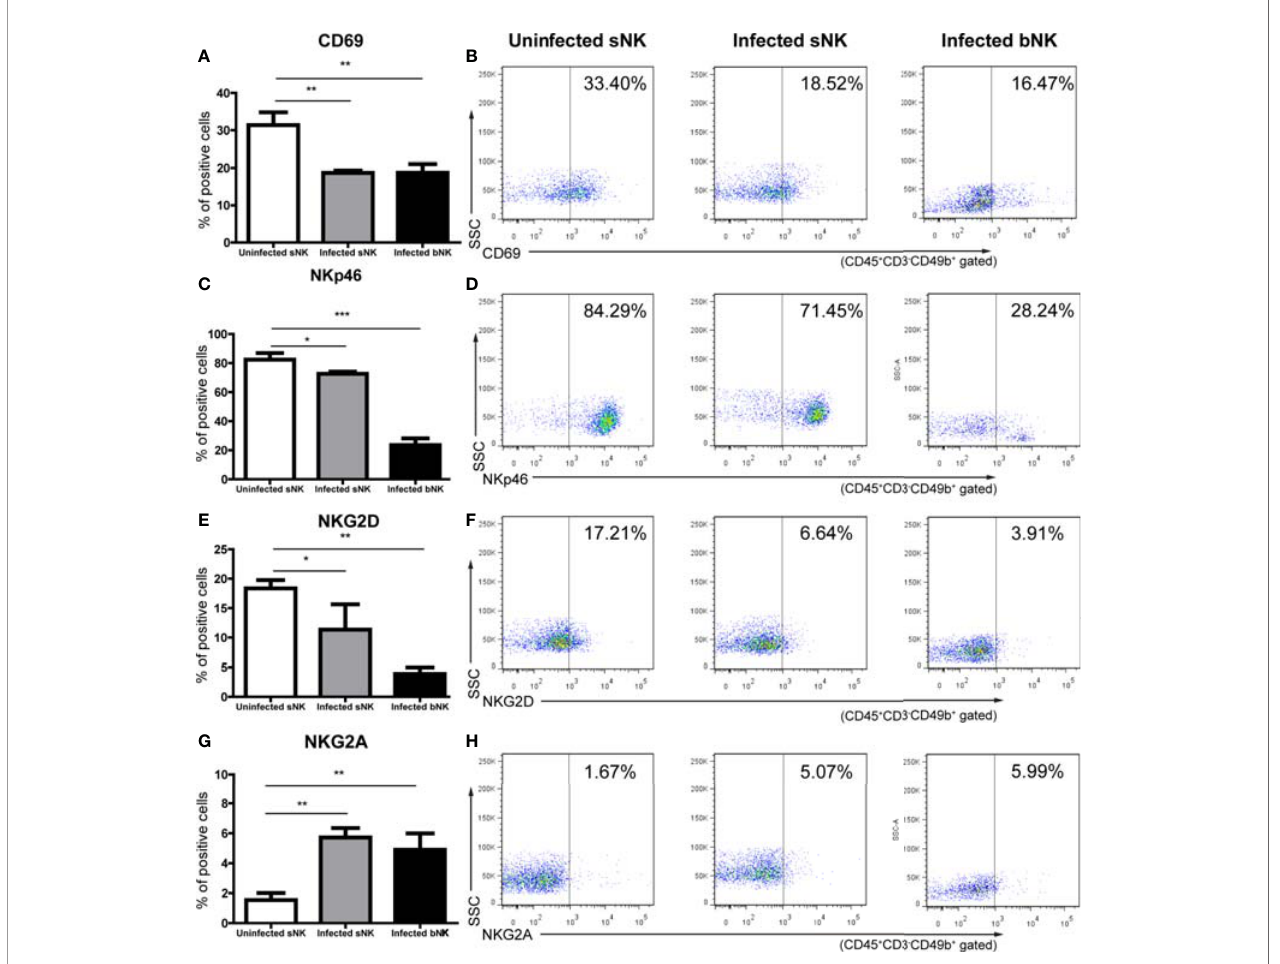
FIGURE 4 | The phenotypes of NK cells changed after A. cantonensis infection. The expression of activation marker CD69 (A, B) , activated receptor NKp46 (C, D) and NKG2D (E, F) , and inhibitory receptor NKG2A (G, H) on the surface of sNK and bNK were detected by FCM. Gating strategy for the mouse CD45 + CD3 - CD49b + NK cell population was shown in Figure S2 . Representative dot plots stained with isotype controls was shown in Figure S5 . Data are expressed as the means ± SD. Data shown represent analysis from two independent experiments with three mice per group. Multiple comparisons of phenotypes between uninfected sNK, infected sNK and infected bNK were performed by ANOVA. * P < 0.05; ** P < 0.01; *** P < 0.001. sNK, NK cells in spleen; bNK, NK cells in